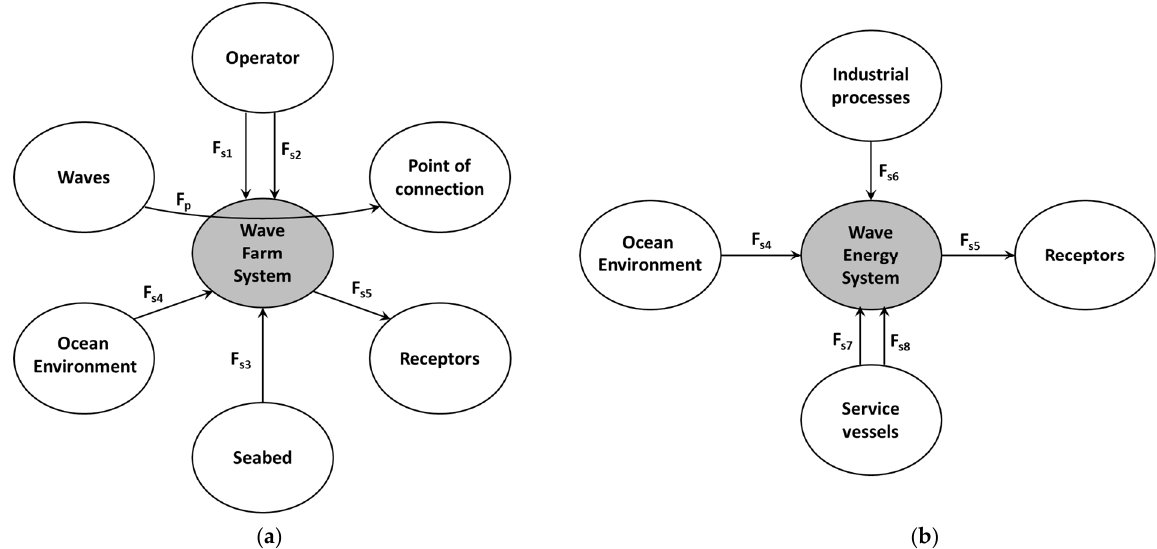
Figure 8. Octopus diagram for the operation phase ( a ) and rest of phases ( b ).